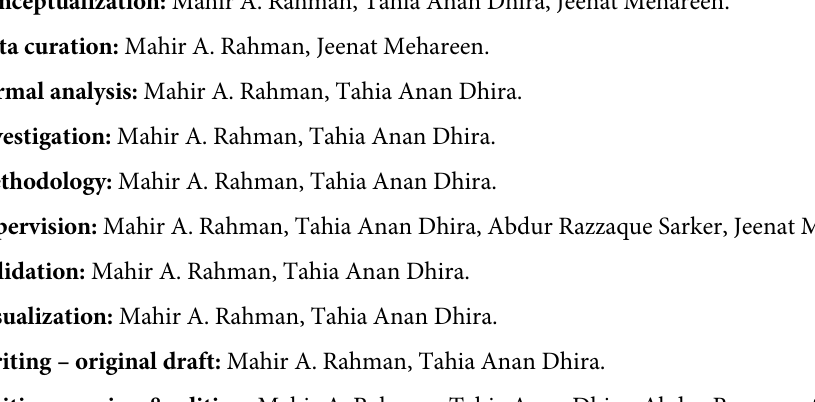
S1 Table. PHQ-9 and GAD-7 items and scores. S2 Table. Pearson’s correlation coefficients (r) between PHQ-9 items and with other ques- tionnaires, ( n = 677). S3 Table. Distribution of PHQ-9 items. S4 Table. Factor determinacy coefficients. S5 Table. Multigroup—CFA: Fit measures of the invariance